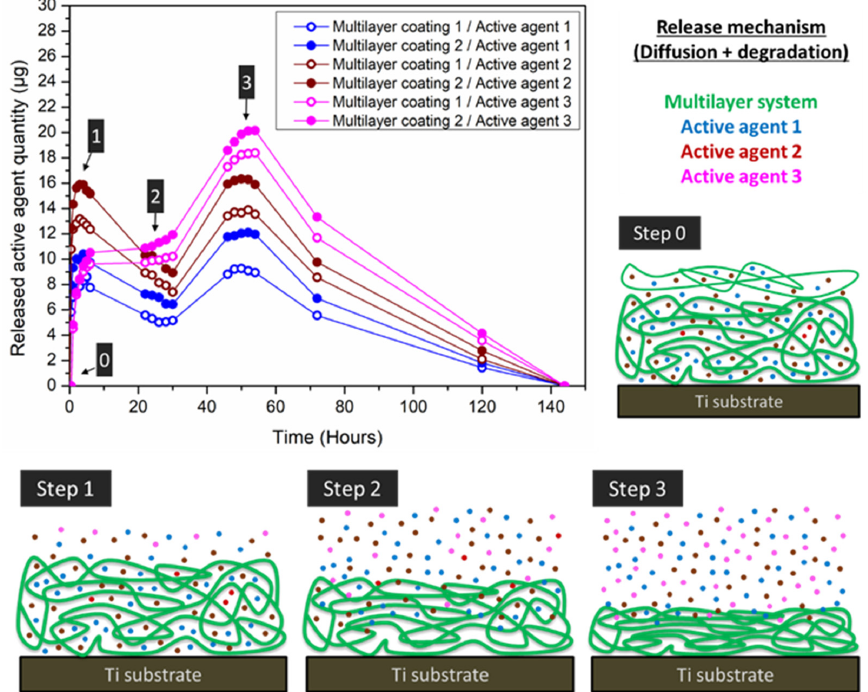
Figure 11. Example of a release-based multilayer coating on Ti surface with cumulative sustained release profile of active agents after 140 h, and the release mechanism from multilayer systems through drug diffusion and multilayer degradation processes.